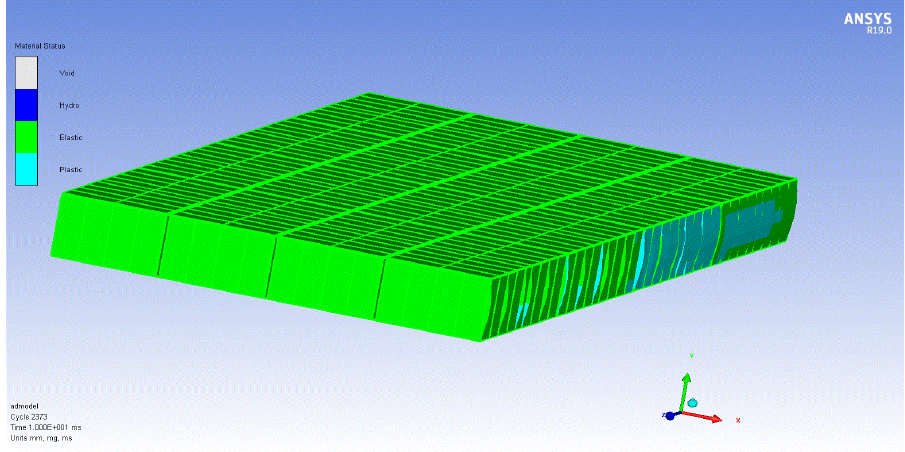
Figure 20. Material statues beyond the mitigation system.